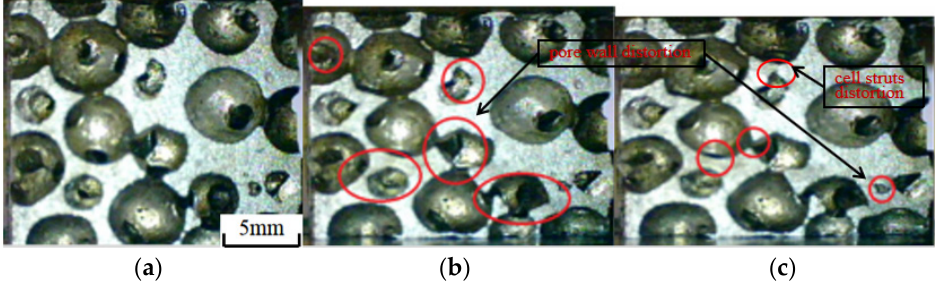
Figure 14. Surface images of the specimen during fatigue test (k = 1.1): ( a ) 0 strain; ( b ) 5% strain; ( c ) 10% strain.